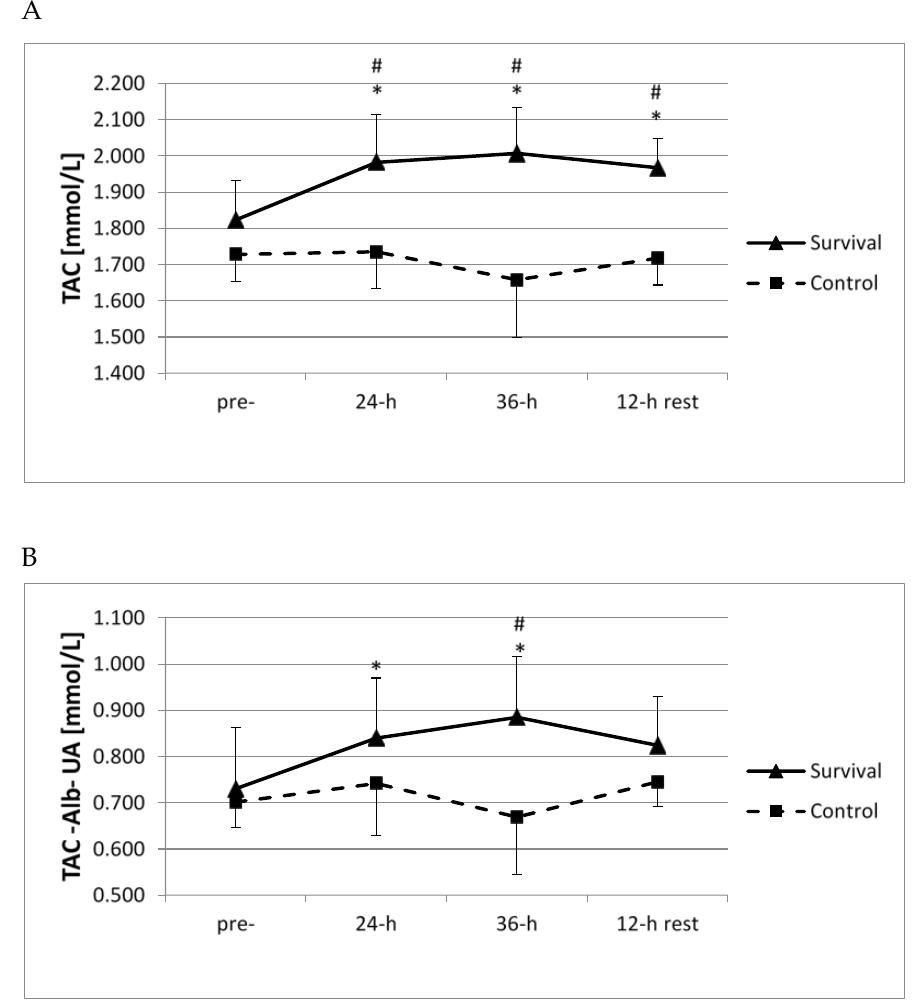
Figure 2. Changes in total antioxidant capacity (TAC) of plasma ( A ) and antioxidant capacity of plasma without albumin (Alb) or uric acid (UA) ( B ) in control group ( n = 11) and survival group ( n = 12). Values are means ± SD. Main effects for TAC: group ( p = 0.00001); group × time ( p = 0.005); Main effects for TAC-Alb-UA: group ( p = 0.001); group × time ( p = 0.04); * significant difference ( p < 0.05) as compared to pre-training (within same group); # significant difference ( p < 0.05) between survival and control groups (at same time point).